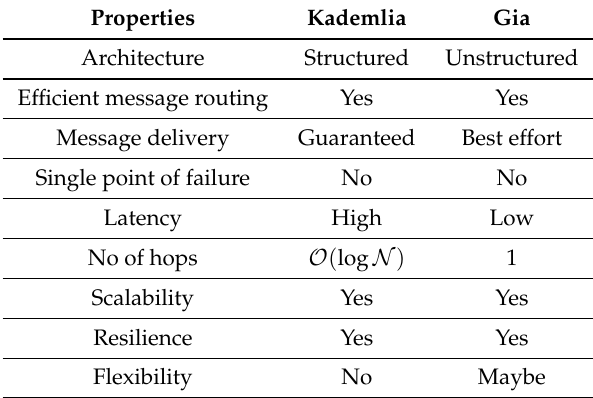
Table 3. Comparison of Kademlia and Gia protocols [26,47,49].